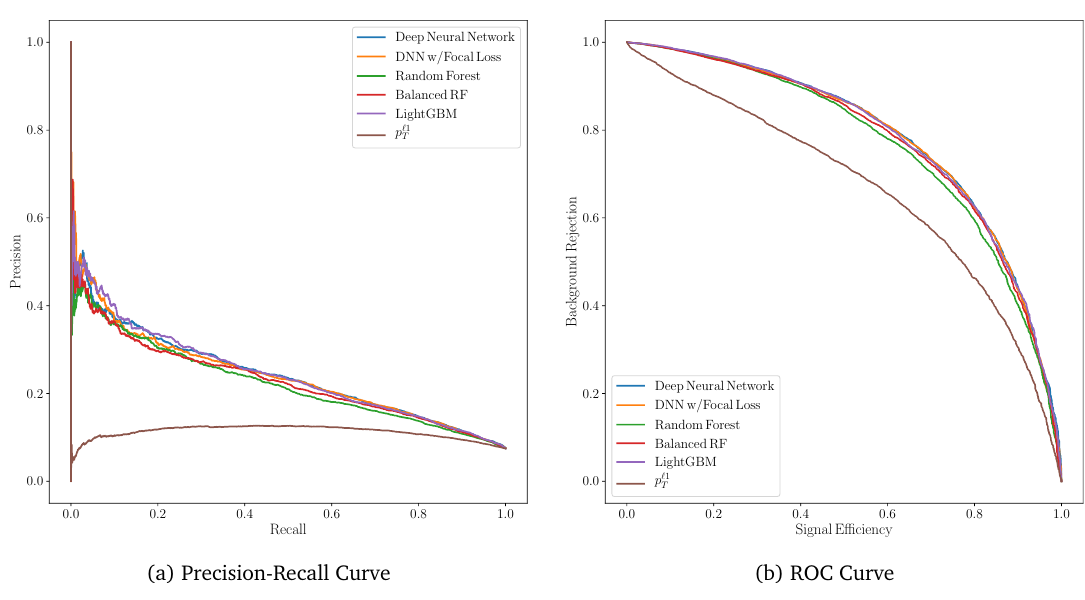
Figure 2: Multiple parameter performance measures. The precision-recall curve is given in 2a, and the ROC curve is shown in 2b. Visually it is clear that the balanced random forest (red) outperforms its unbalanced counterpart (green). More strikingly, all of the machine learning models significantly outperform the kinematic variable (cid:96) 1 p . Note that recall is equivalent to signal efficiency, but precision is not related to T background